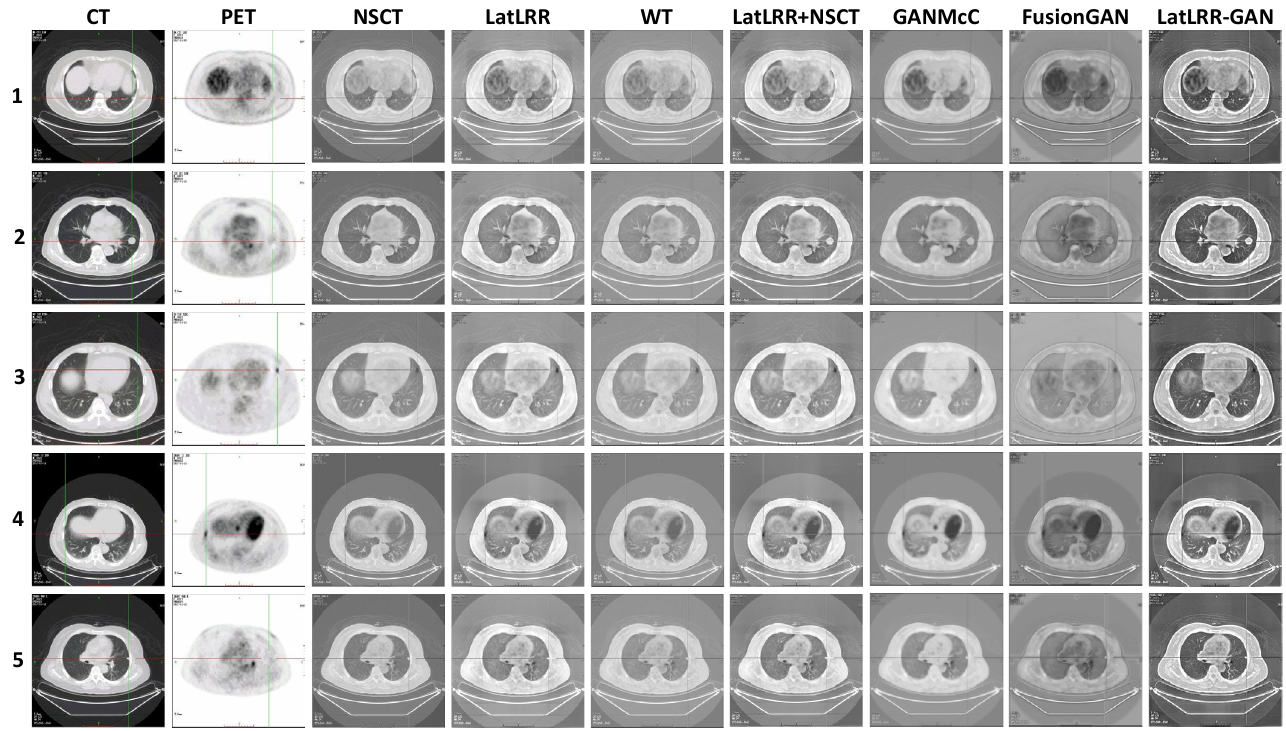
Figure 3. The fusion results of CT lung window images and PET images. Method 1: NSCT; Method 2: LatLRR; Method 3: WT; Method 4: LatLRR+NSCT; Method 5: GANMcC; Method 6: FusionGAN; Method 7: LatLRR-GAN.